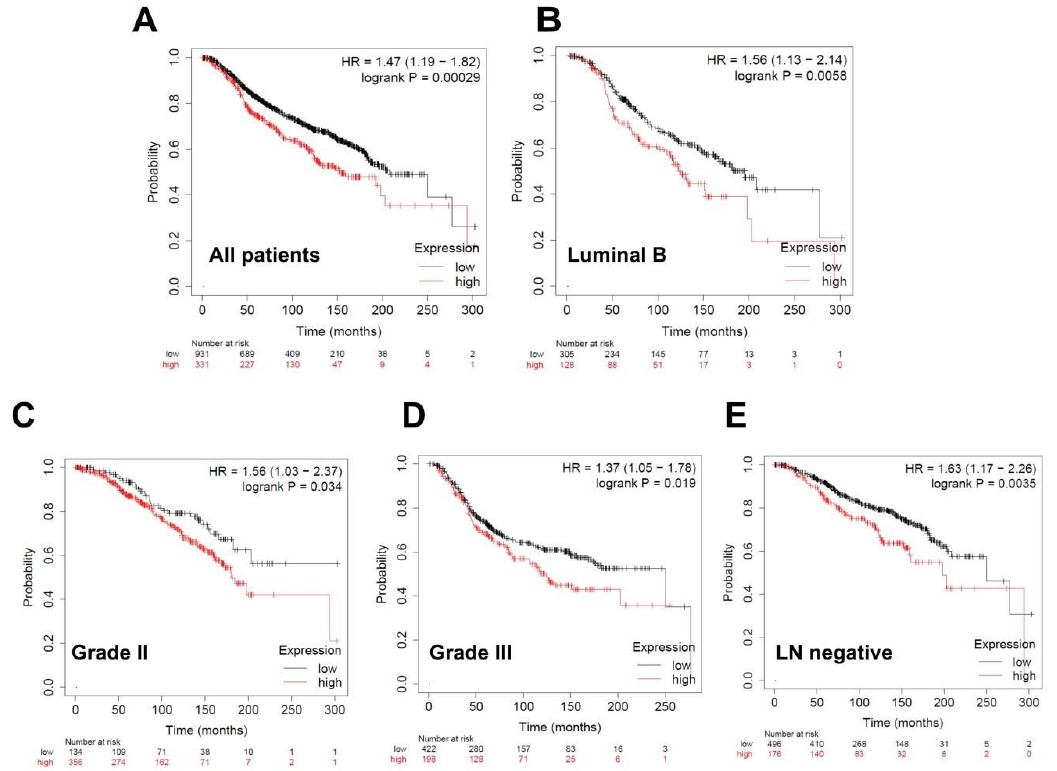
Figure 8. Overall survival curves according to miR-181b expression in breast cancer patients. High miR-181b expression correlated with worse outcome. Kaplan–Meier curves are plotted for expression of miR-181b in ( A ) all patients ( n = 1262), ( B ) luminal B patients ( n = 433), ( C ) patients with grade II ( n = 383) and ( D ) patients with grade III ( n = 620), and ( E ) LN-negative patients ( n = 672). Curves were analyzed using the log-rank test. Log-rank p values and hazard ratios are shown.